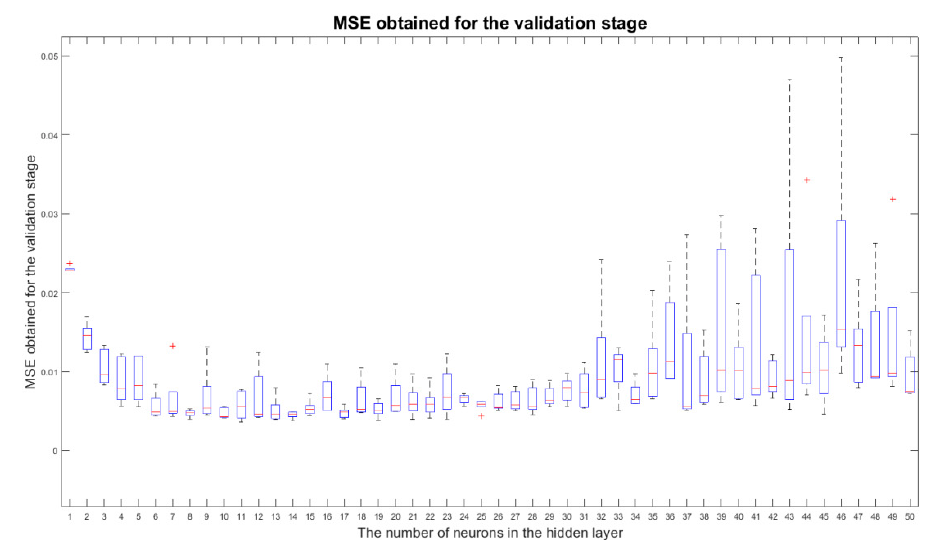
Figure 6. Mean squared error ( MSE ) obtained for the neural network structure with a certain number of neurons in a hidden layer—results for the validation stage.